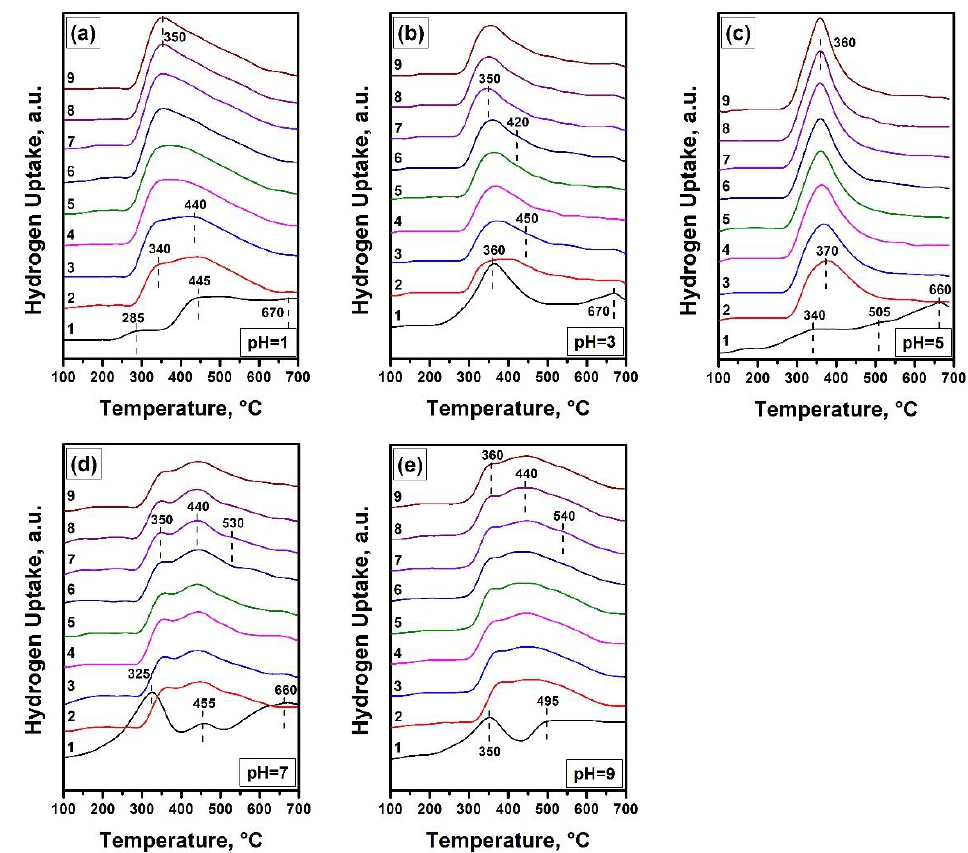
Figure 6. TPR profiles of the Ni-Mg-O samples obtained at various pH: ( a ) pH = 1; ( b ) pH = 3; ( c ) pH = 5; ( d ) pH = 7; ( e ) pH = 9. ( c ) pH = 5; ( d ) pH = 7; ( e ) pH =